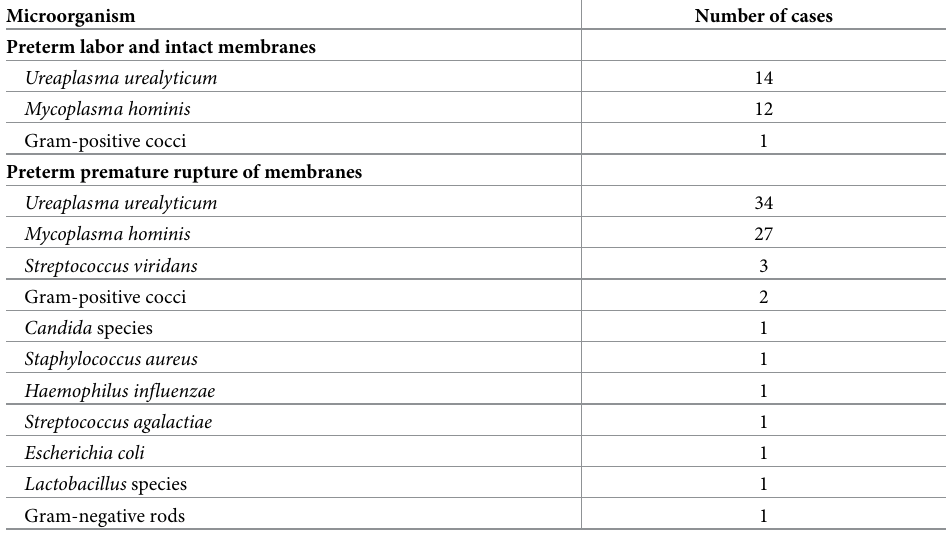
Table 1. Types of microorganisms isolated from the amniotic fluid of women with preterm labor and preterm premature rupture of membranes.